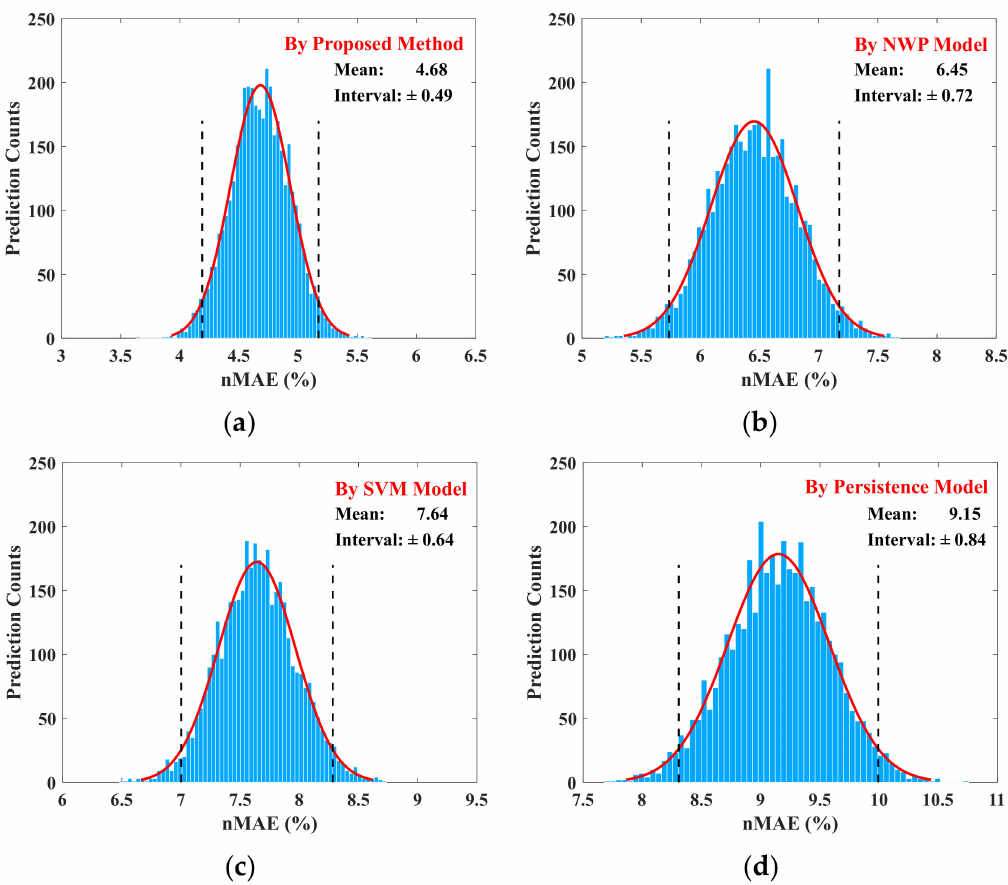
Figure 15. Histogram comparison of the forecast nMAE: ( a ) using the proposed method; ( b ) using the NWP model; ( c ) using the SVM model; ( d ) using the persistence model.